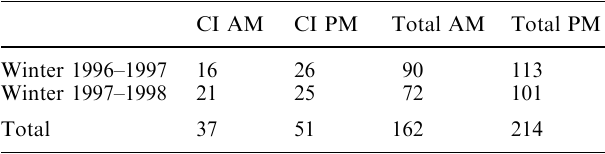
Table 4. Numbers of twilights with PSC incidence (out of total number of measurements) as deduced from CI reddenings for